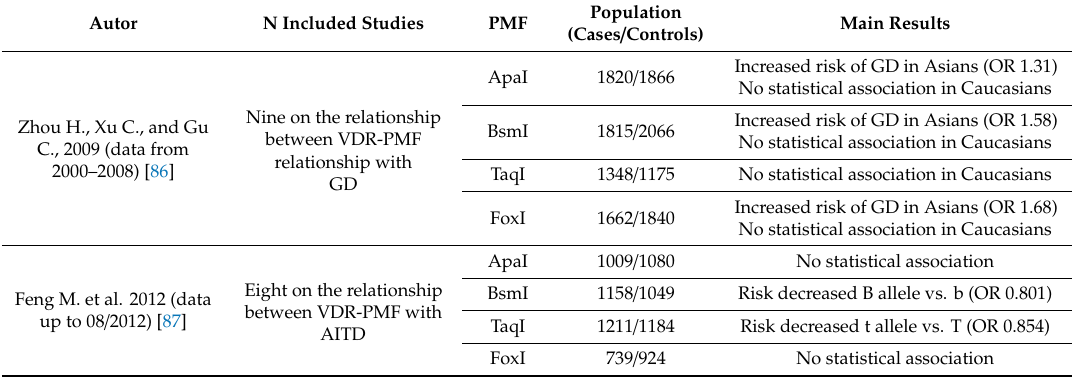
Table 1. Meta-analyses summarizing the association between VDR polymorphisms and AITD. Autor Main